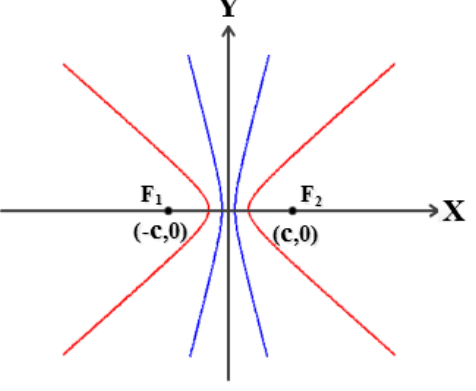
Figure 11. Diagram of the hyperbolic curves.